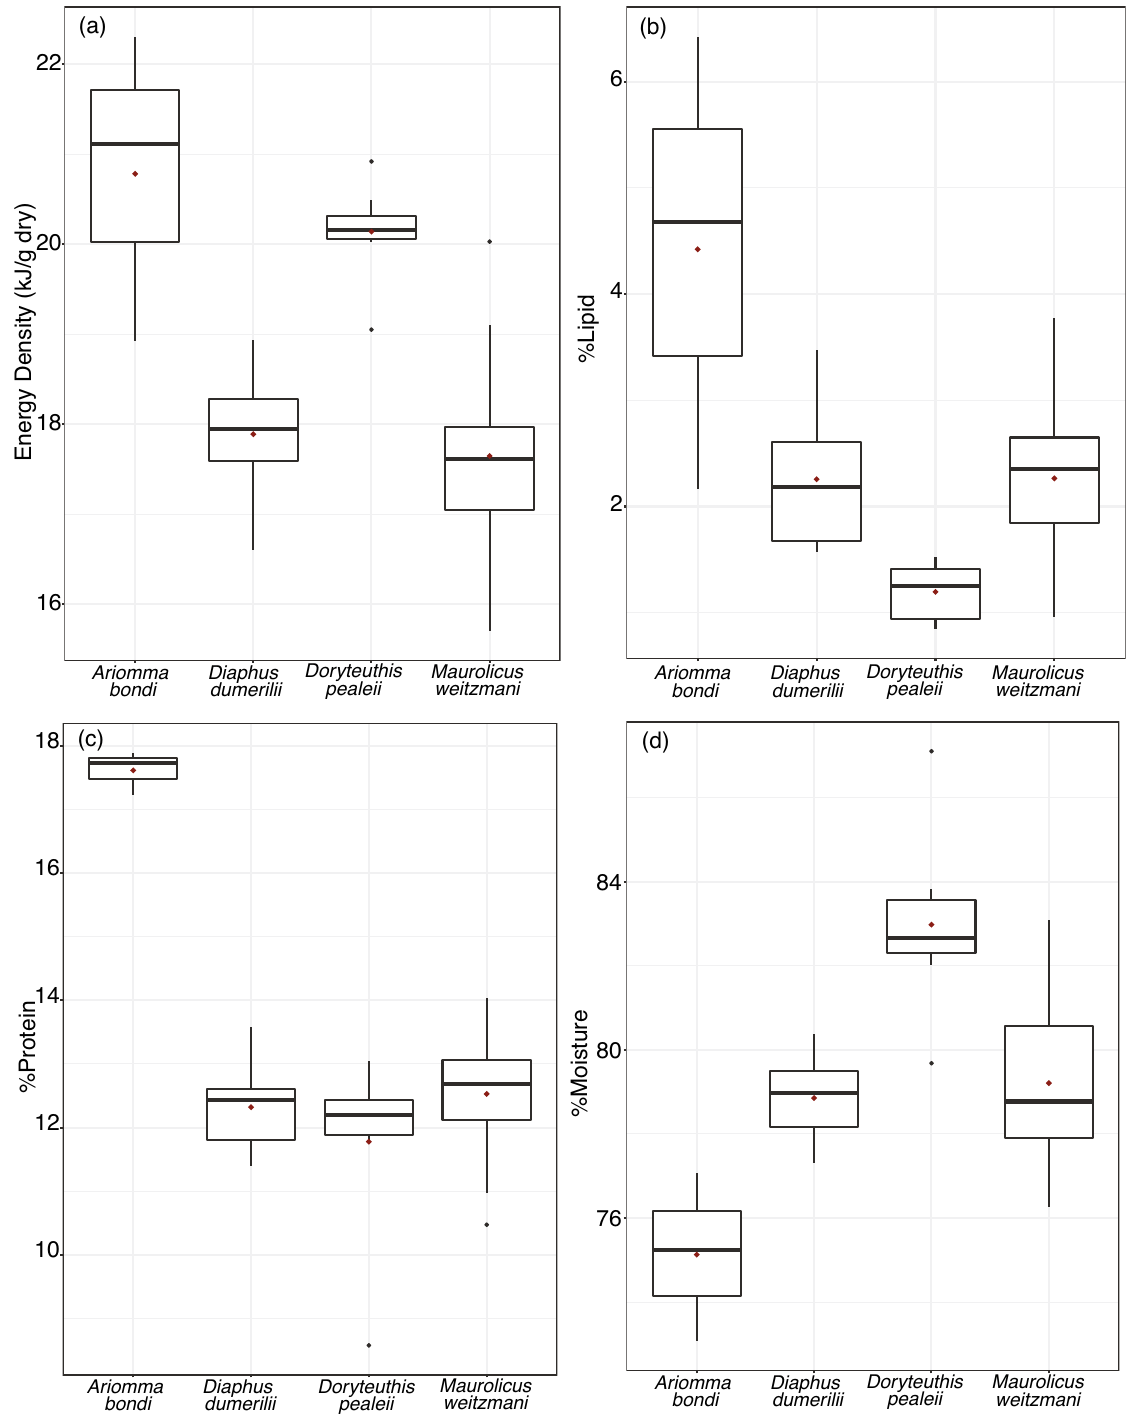
Figure 5. Proximate composition (mean, median, 50, 75 percentiles and outliers) of Rice’s whale ( Balaenoptera ricei ) prey from the Gulf of Mexico, including ( a ) energy density (kJ/g dry), ( b ) %lipid, ( c ) %protein and ( d ) %moisture